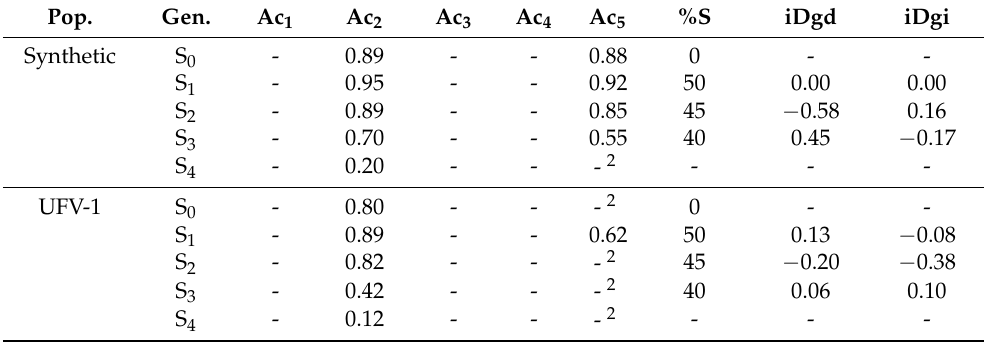
Table 2. Accuracies 1 of phenotypic mass selection and pedigree-based BLUP based on EV, percent of selected plants (%S), and increments of direct (iDgd; mL/g) and indirect (iDgi; g/plant) genetic gains per generation with pedigree-based BLUP, relative to phenotypic mass selection, in the popcorn and in silico